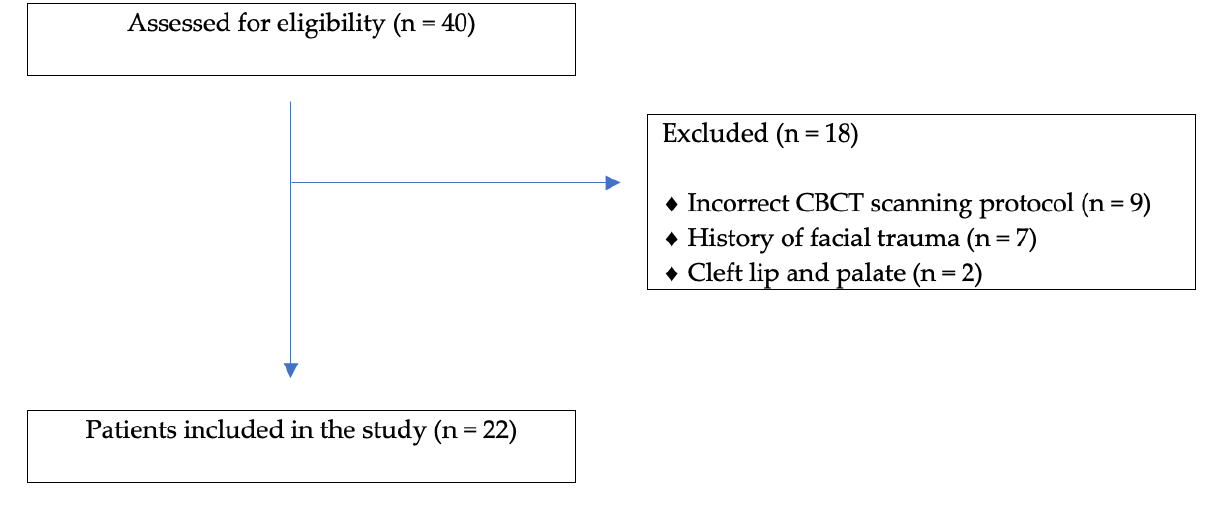
Figure 1. Flowchart. Table 1. Study sample characteristics.